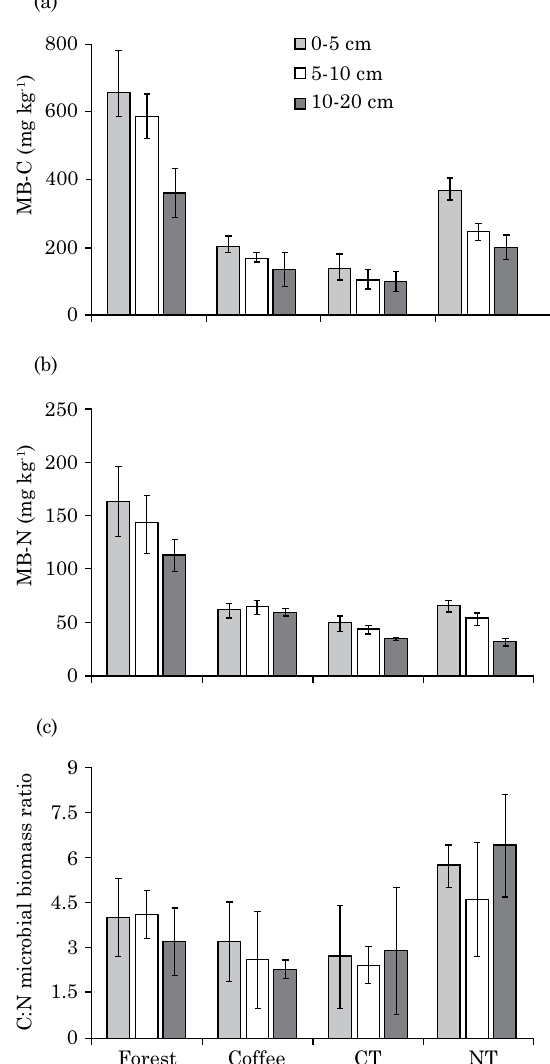
Figure 2. Microbial biomass C (MB-C) (a), and N (MB-N) (b) and C:N microbial biomass ratio (c) of a Brazilian Oxisol 24 years after forest conversion to a perennial crop with coffee or annual grain crops (maize and soybeans) in conventional tillage or no-tillage from three layers (0-5, 5-10 and 10-20 cm). Average of three replications. Bars indicate standard deviation.